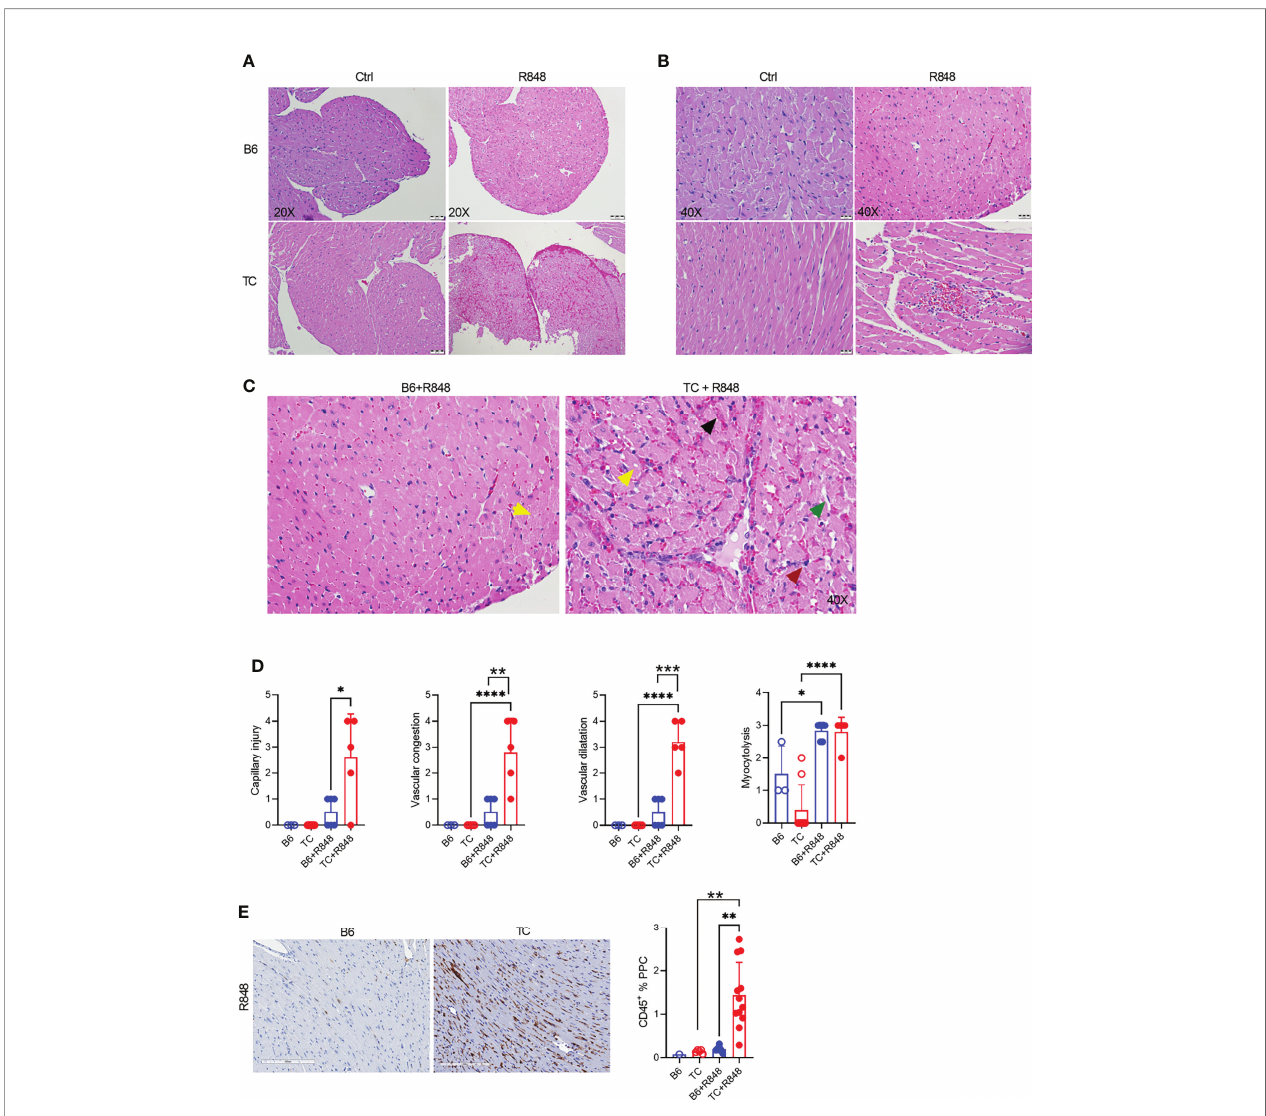
FIGURE 1 | TLR7 activation induces cardiovascular pathology in TC mice. Representative H&E-stained heart sections of untreated and R848-treated B6 and TC mice at 20X (A) and 40X (B) magni fi cation (scale bars: 50 um and 20 um, respectively) at week 3. (C) Representative H&E staining from R848-treated B6 and TC mouse at 40X showing in the TC mouse: vascular congestion (black arrow); vascular dilatation (green arrow); myocytolysis with vacuolization (yellow arrow); and capillary injury with enlarged endothelial cell (red arrow). Capillary injury (D) , vascular congestion, vascular dilatation and myocytolysis scores respectively, R848- treated B6 mice were used as a control. (E) CD45 staining with representative sections on the left (20X magni fi cation, scale bar: 200 um) and quantitation of the right (PPC: pixel per cell). n = 1 - 5 untreated mice, n = 5 - 12 treated mice per strain. t tests and 1-way ANOVA with multiple comparison tests, * P < 0.05, ** P < 0.01, *** P < 0.001; **** P <